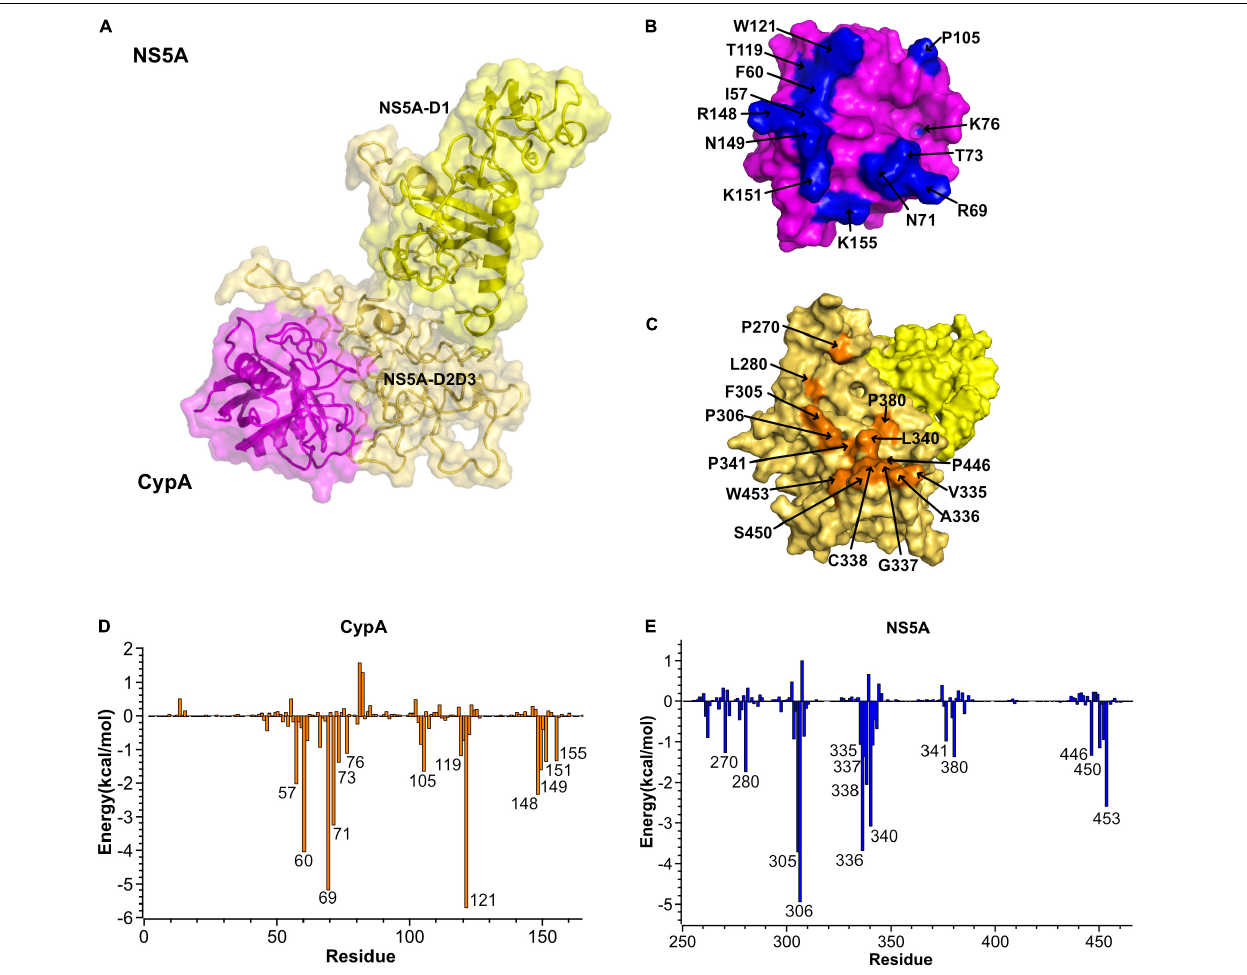
FIGURE 4 | Predicted CypA–NS5A interaction sites. (A) Cartoon and surface representation of the most representative structure of CypA (magenta) in complex with NS5A (yellow). NS5A uses its domain I and domain II (NS5A-D2D3) to bind CypA. (B,C) Surface representations of interacting residues in CypA (top) and NS5A (bottom). The identified hot-spot residues in CypA and NS5A are labeled and highlighted in blue and orange in the surface representations, respectively. (D,E) The per-residue contribution to the CyPA:NS5A binding energy (kcal/mol). Only residues with total energies above 1 kcal/mol are labeled. CypA, cyclophilin A; NS5A, non-structural protein 5A.